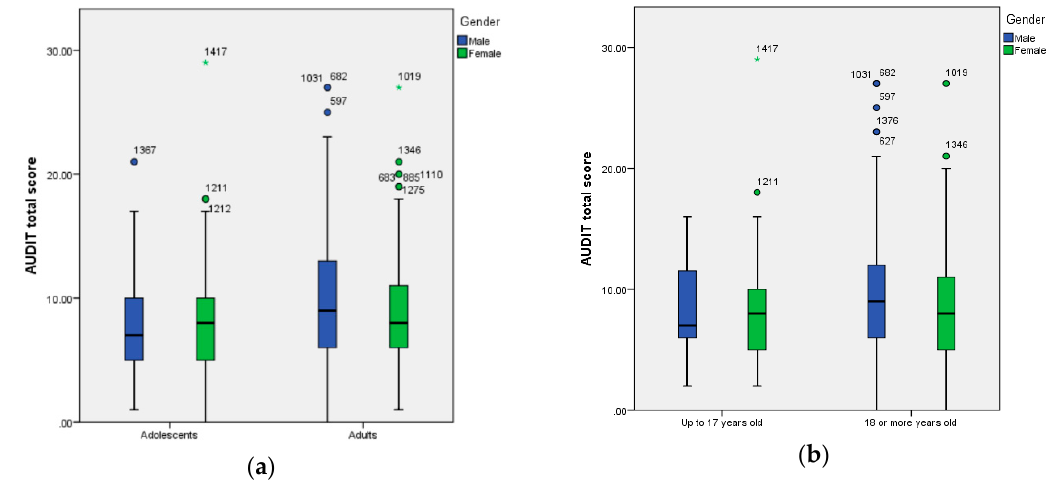
Figure 2. ( a ) Boxplot of AUDIT total scores by age (adolescents and young adults) and gender (male, female); ( b ) boxplot of AUDIT total scores by age limit for alcohol drinking in Spain (up to 17 years old and 18 or more years old) and gender (male and female).